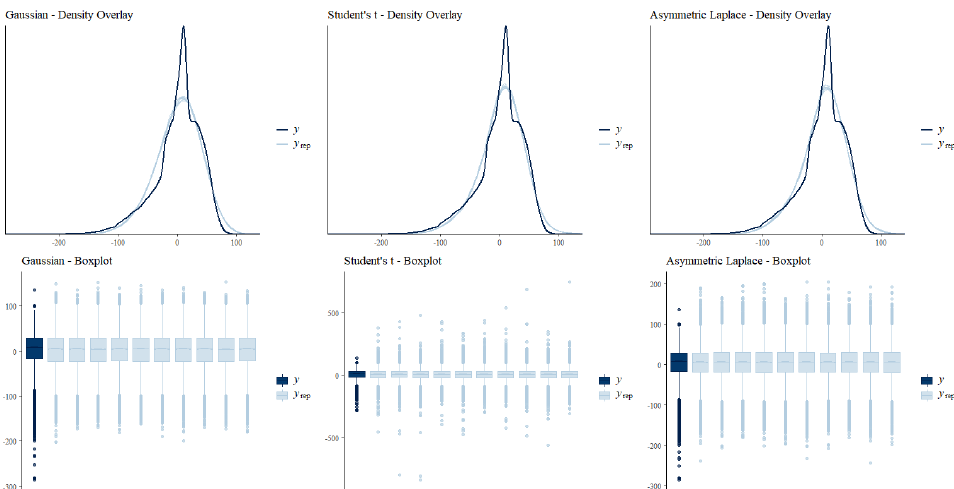
Figure 1. Graphical posterior predictive checking results. Top: Density overlay (based on ten posterior draws for each of the models) restricted to the range of − 290 to 140 on the x axis to facilitate a comparison of model fit based on the main part of the empirical distribution (i.e., observed values of reading efficiency y ranged from − 286.11 to 135.88). Bottom: Boxplots of the original data (dark blue) and ten draws of the posterior predictive distribution (boxes in light blue) to facilitate comparison of the sampled values between the three models.